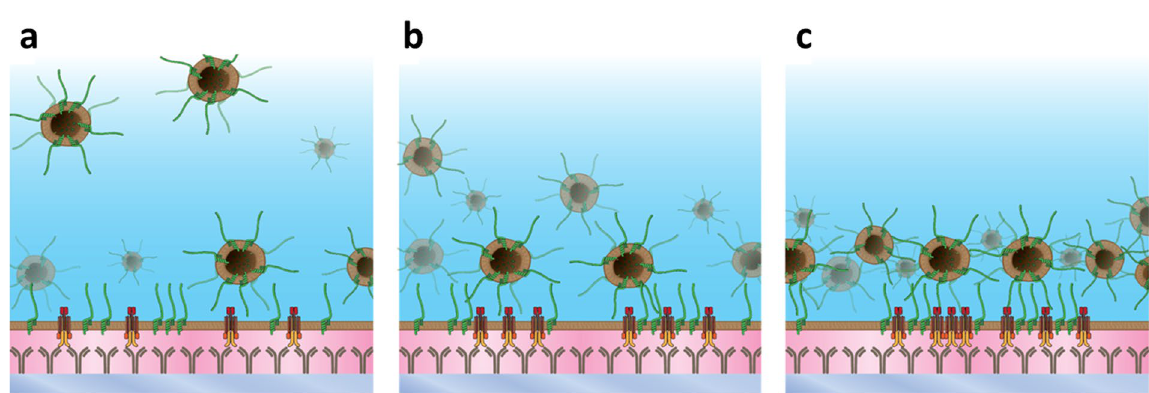
Figure 5. Model for LAT (green) recruitment following T cell activation through the TCR (yellow and red) pathway via antibodies (grey). ( a ) Control conditions showing LAT vesicles up to 500 nm in depth as well as pre-clustered LAT in the plasma membrane. ( b ) 4 minutes after activation showing the recruitment of LAT vesicles to the vicinity of the plasma membrane. ( c ) 8 minutes condition showing the accumulation of recruited vesicles proximal to the membrane forming a dense signalling